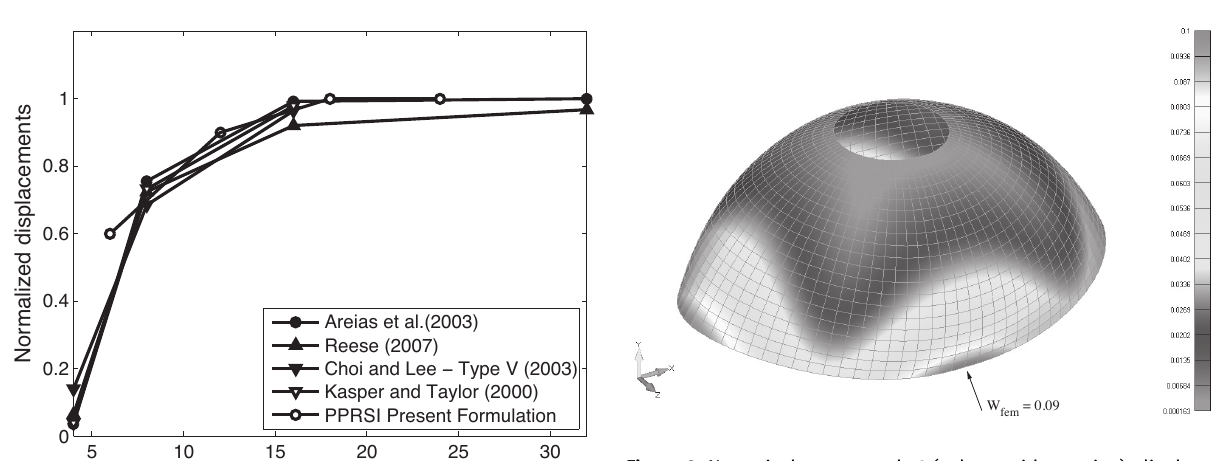
Figure 8: Numerical test example 3 (a dome with opening): displace- ment fields using contour plots point of view we define the radius R = 10 mm and the main thickness s = 0.04 mm as depicted in Figure 6. Further- more, the main elastic and isotropic material properties are: Young modulus E = 6.825 · 10 7 N/mm 2 and Poisson coefficient ν = 0.3; R = 250 or s = 0.004. We use the clas- s R sical analytical exact solutions w = 0.0940 mm from ex